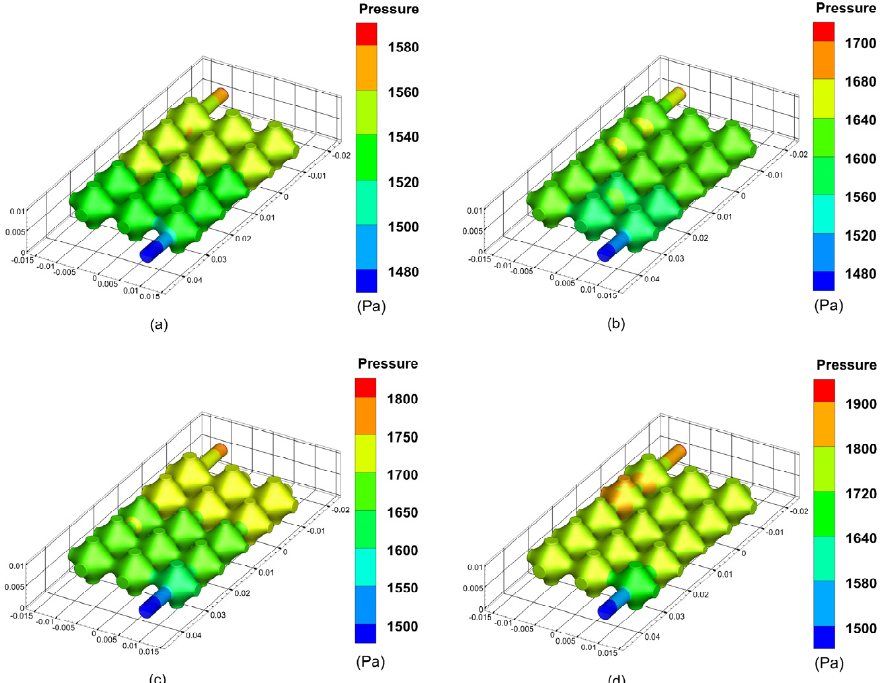
Figure 5. Results of wall pressure simulations of the class of vascular flow channels at different perfusion pressures: ( a ) 12 mmHg; ( b ) 13 mmHg; ( c ) 14 mmHg; ( d ) 15 mmHg.